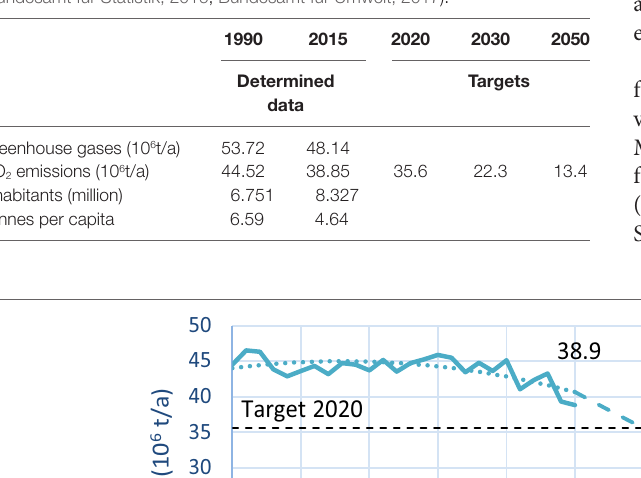
TaBle 1 | Survey of the greenhouse gas and carbon dioxide emissions of Switzerland, population figures, and the determination of the output per capita (Bundesamt für Statistik, 2016; Bundesamt für Umwelt,